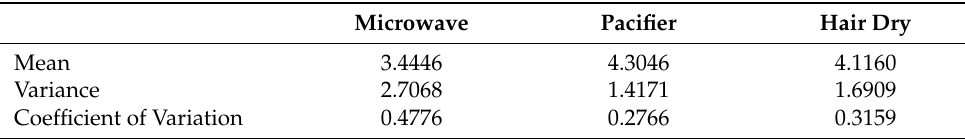
Table 6. CVs of three products’ satisifaction indicator.